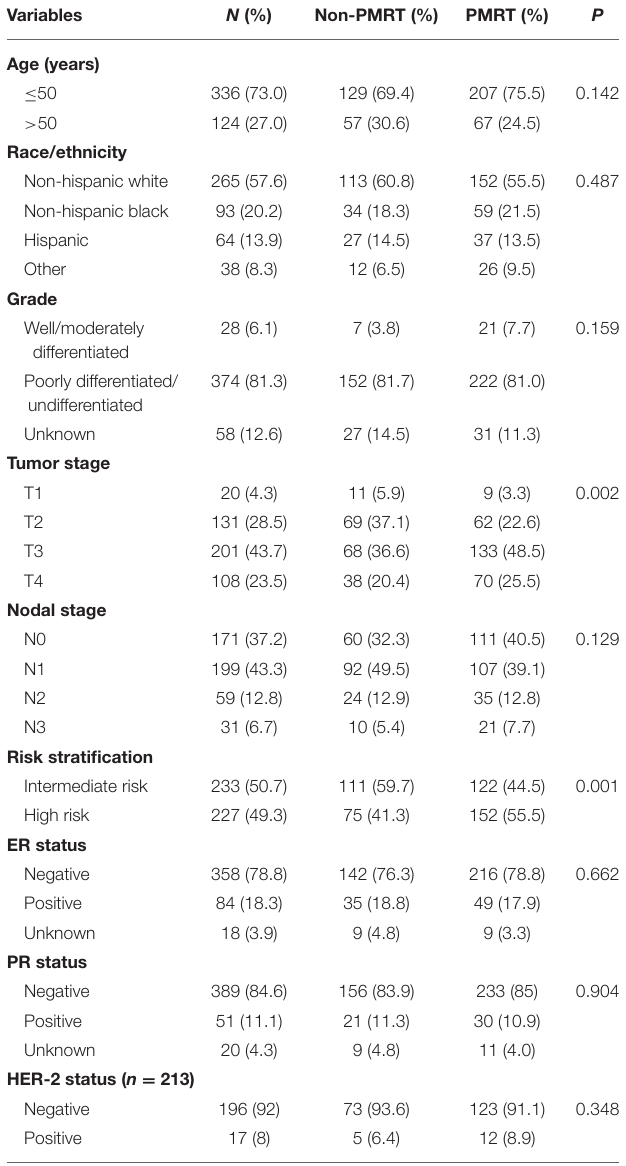
TABLE 1 | Patient demographic and clinical